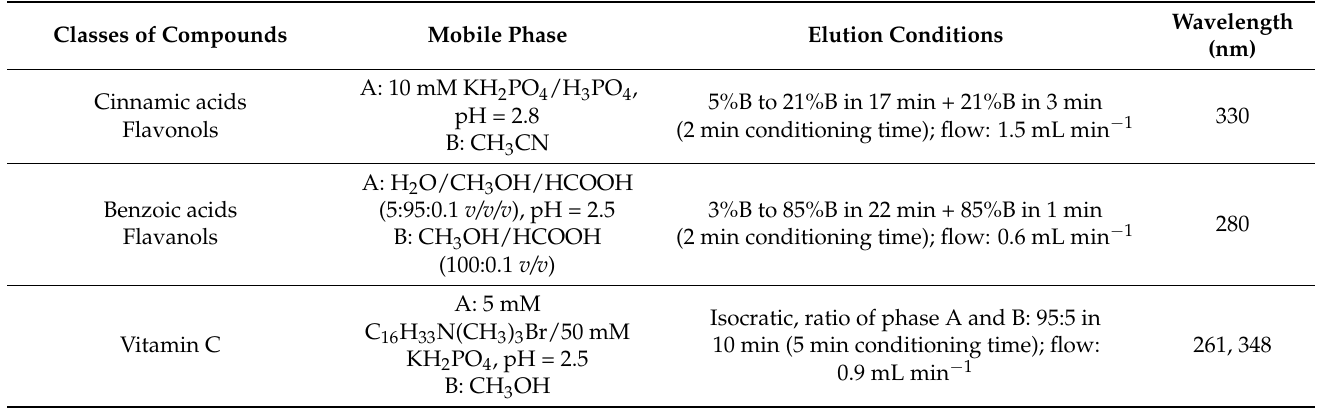
Table 1. Mobile phases, elution conditions, and wavelength used to detect the five classes of compounds with HPLC analysis.